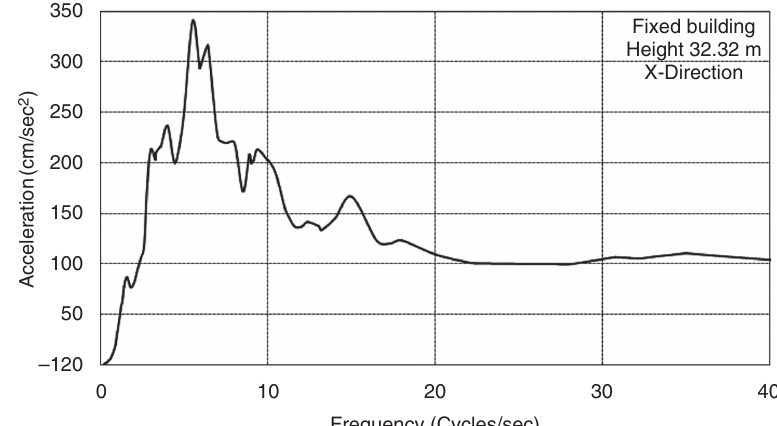
Fig. 6. Spectral Acceleration in X-direction ( fi xed